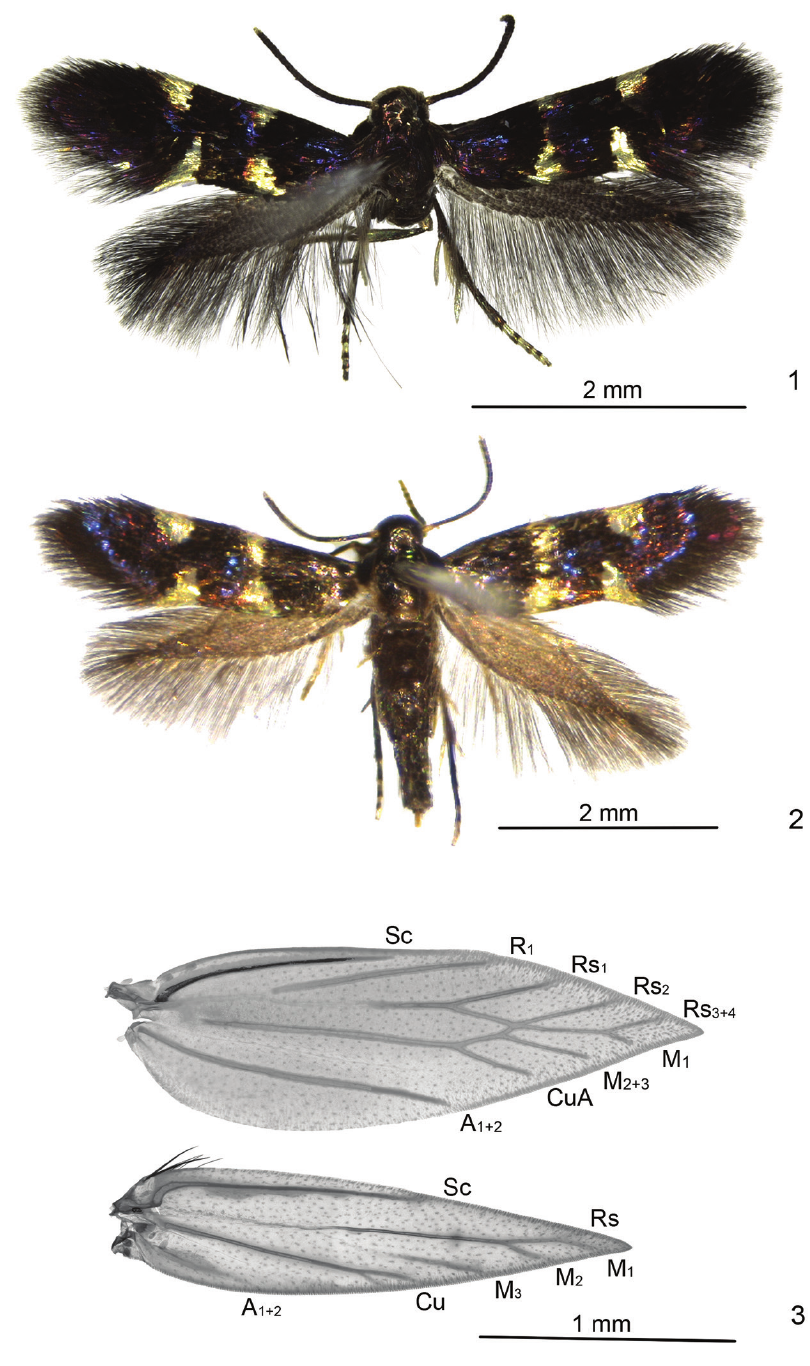
Figures 1–3. Adult and wing venation of Antispila sinensis sp. n. 1 Adult, paratype, male, BXS130941 2 Adult, paratype, female, SDNU_JN150947 3 Wing venation, female, slide No. LTT12874W,